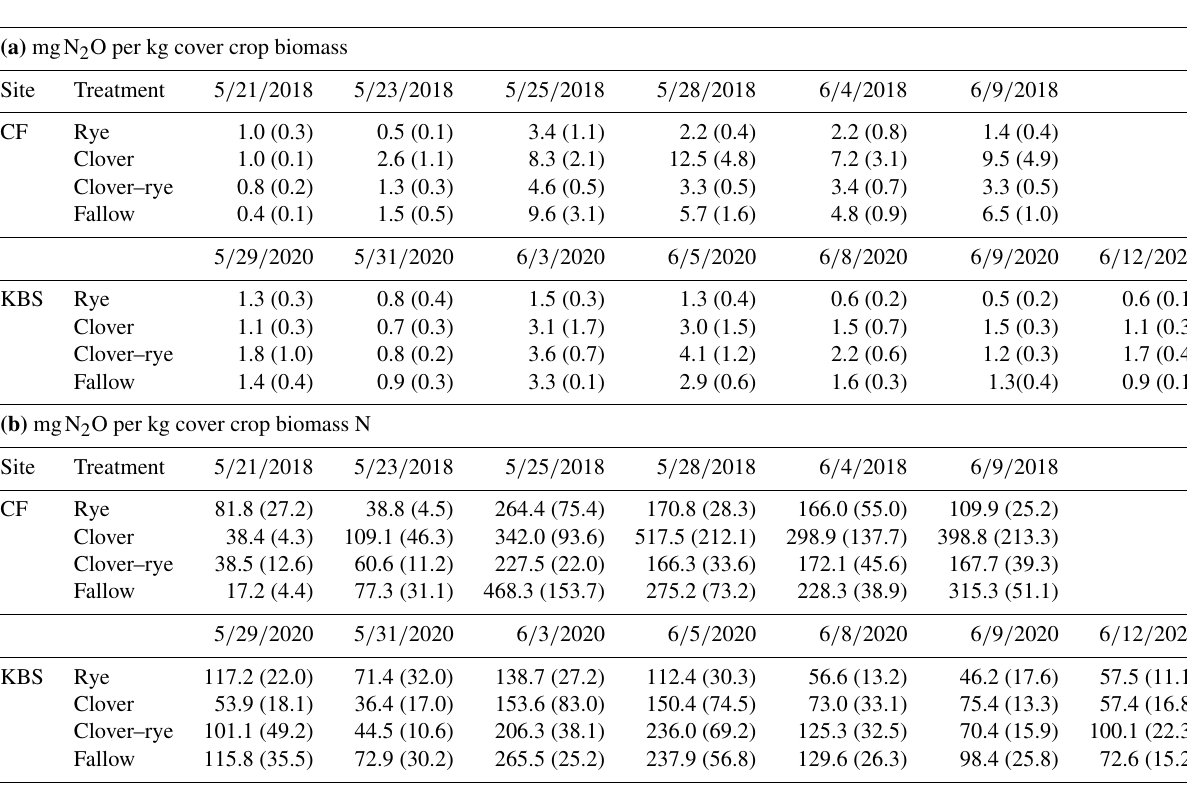
Table A2. Means (standard error) for ratios of milligrams of N 2 O to kilograms of cover crop biomass (a) and for ratios of milligrams of N 2 O to kilograms of biomass N (b) by site and by treatment for each N 2 O sampling date (month/day/year).